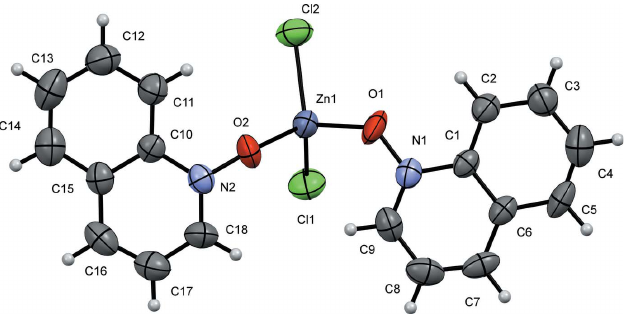
Figure 1 A view of compound ( I ), showing the atom labeling. Displacement ellipsoids are drawn at the 50% probability